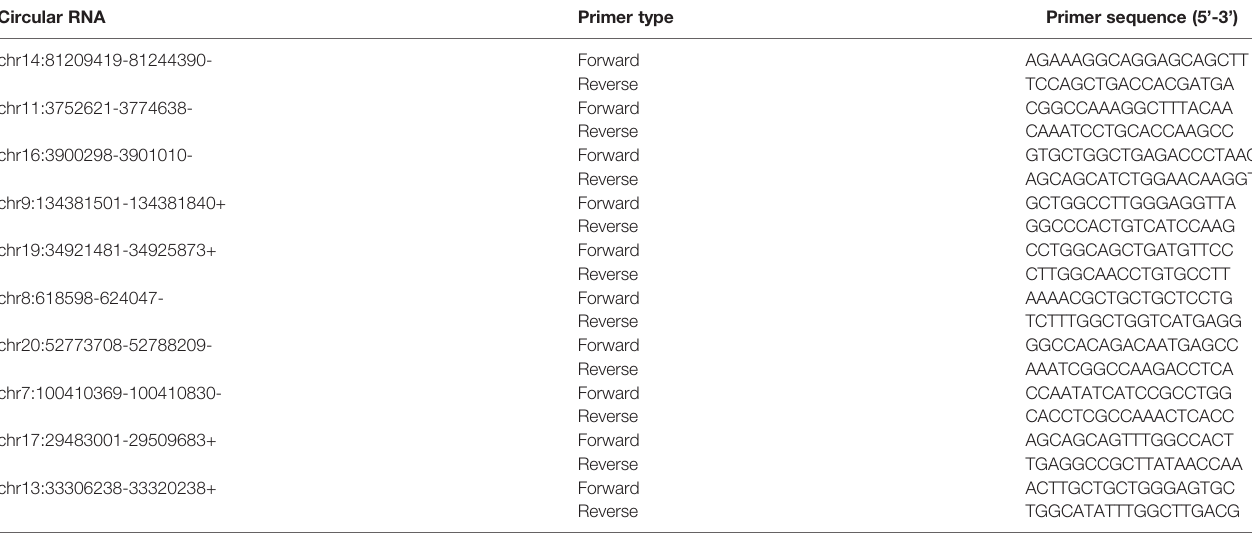
TABLE 2 | The primers used for quantitative real-time PCR (qRT-PCR) experiments. Circular